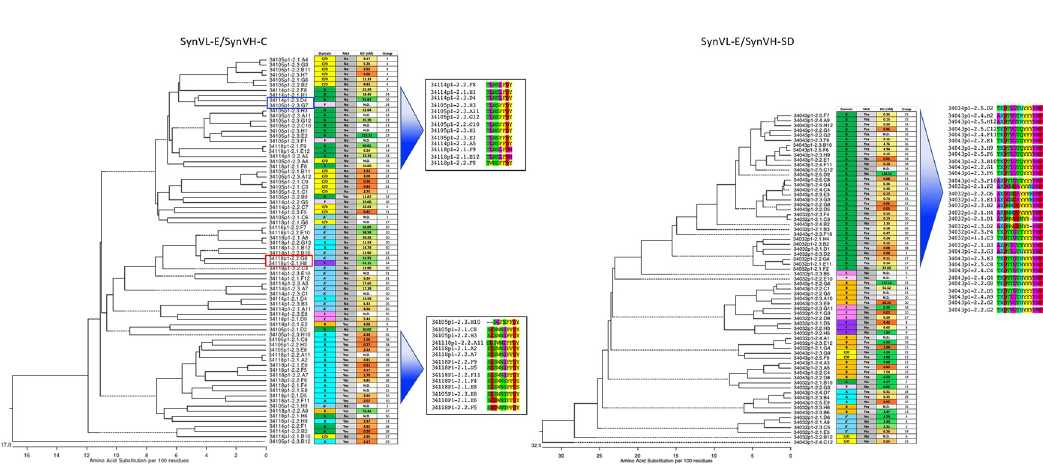
Fig 5. Related clones generally converge on the same epitope bin. A sequence dendrogram based on V λ -VH is shown beside epitope binning, mouse cross reactivity results and clonotype assignment for SynVL-E/SynVH-C (left) and SynVL-E/SynVH-SD (right). For the SynVL-E/SynVH-C cohort, CDR-H3 is shown for two groupings. A set of GrnG binders (top inset) and a set of GrnA binders (bottom inset) show highly related CDR-H3s. In general, related sequences tend to converge on the same epitope bin, but examples of closely related sequences recognizing different bins could also be seen (red and blue